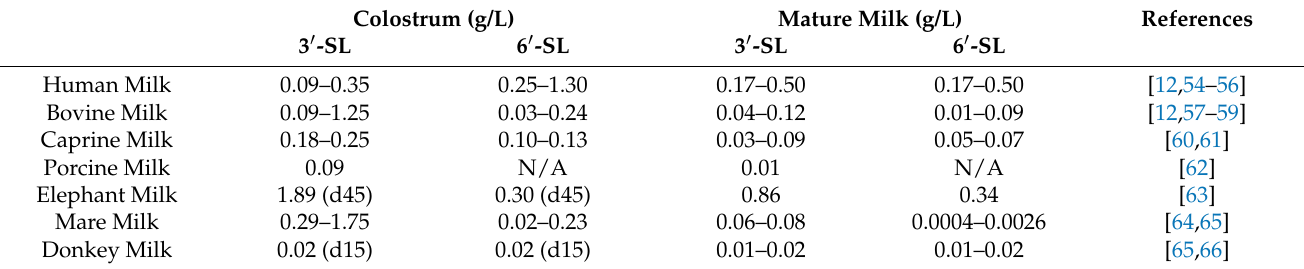
Table 1. Concentration of 3 (cid:48) sialylactose (3’-SL) and 6 (cid:48) sialylactose (6’-SL) in the colostrum and mature milk of different animal species. Colostrum (g/L) Mature Milk